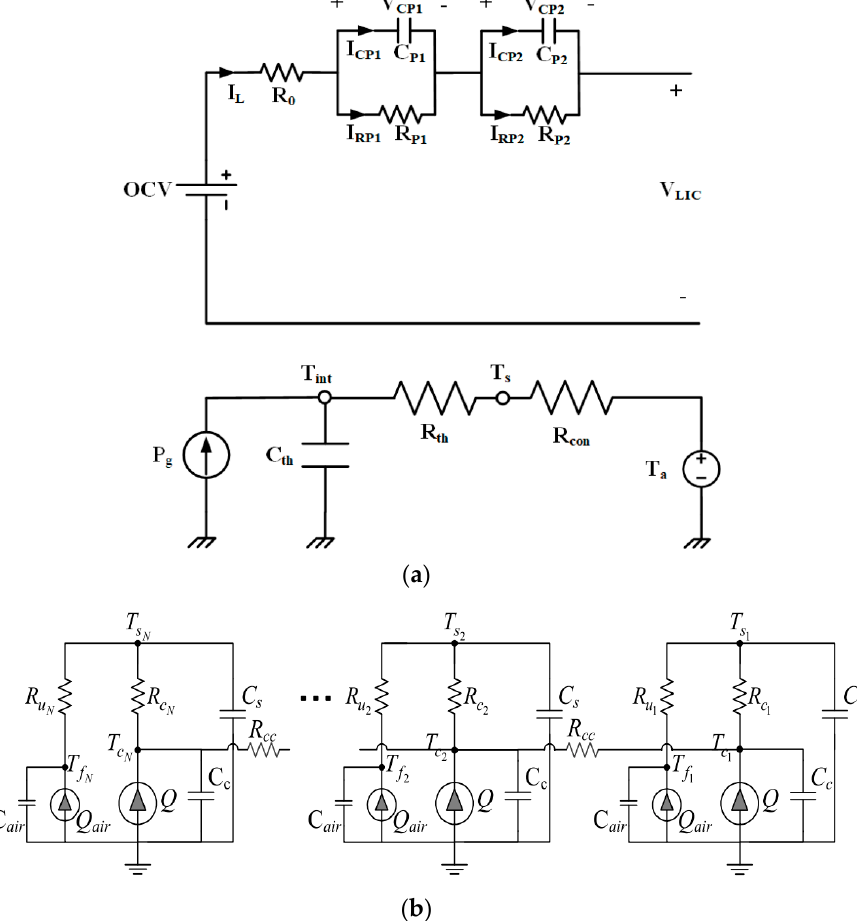
Figure 11. ( a ) 0D electro-thermal model for an LIC cell, reproduced with permission from [121]. Copyright 2020, Elsevier. ( b ) Lumped parameter thermal model of SC string including several cells, reproduced with permission from [123]. Copyright 2020, IEEE.